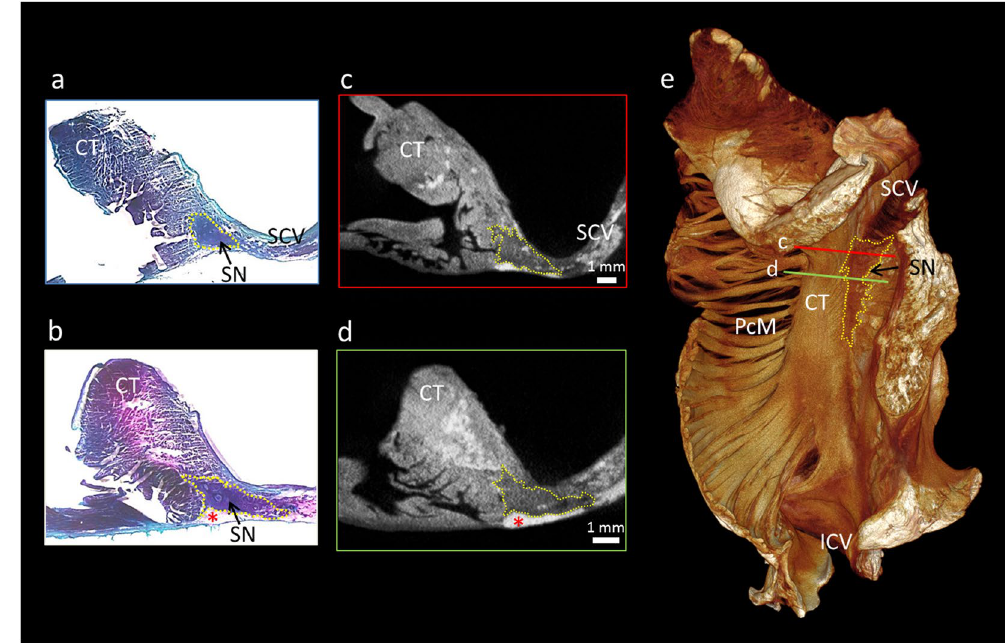
Figure 1. Micro-CT allows objective discrimination of the human sinus node. This figure demonstrates high resolution (28 × 28 × 28 µ m 3 ) micro-CT data from part of the right atrium containing the sinus node. For this figure, the sinus node is outlined in yellow in short-axis micro-CT sections ( c , d ) and in matching histological sections taken from the same sample ( a , b ). The plane of section in c and d is shown on the 3D volume rendering (endocardial view) ( e ). The sections are available to view without the outlines in the supplementary Fig. S2. CT- terminal crest, ICV- inferior caval vein, PcM- pectinate muscles, SCV- superior caval vein, SN- sinus node, * - indicates epicardial